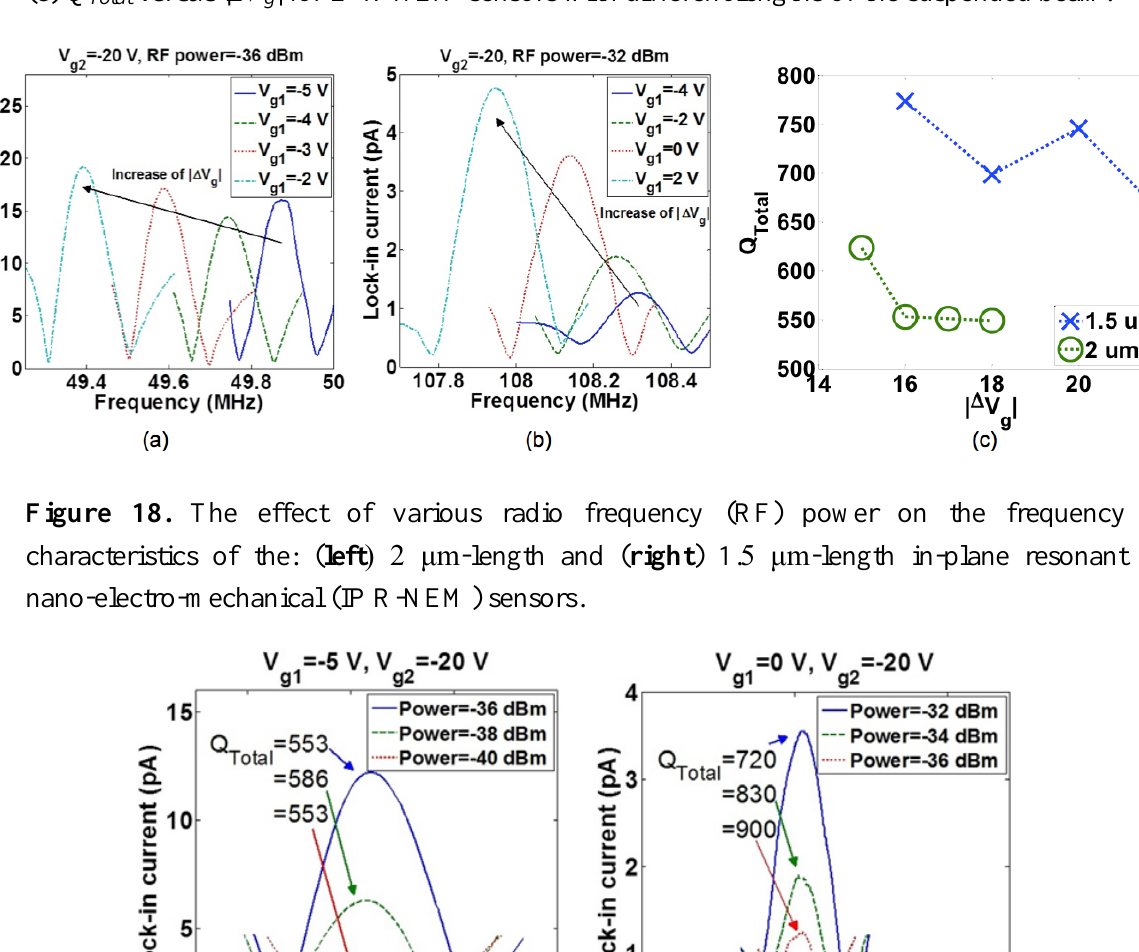
Figure 17. The impact of changing V on the resonance frequency of: ( a ) 2 μm-length and g1 ( b ) 1.5 μm-length in-plane resonant nano-electro-mechanical (IP R-NEM) sensors. ( c ) Q versus | ΔV | for IP R-NEM sensors with different lengths of the suspended beam. Total g